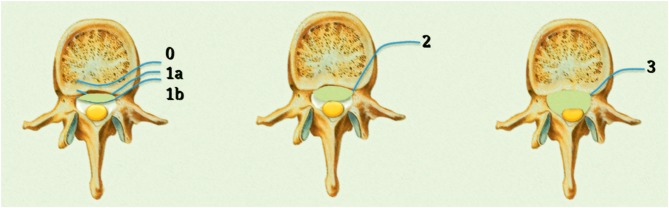
Bilski classification of epidural spinal cord compression (ESCC).